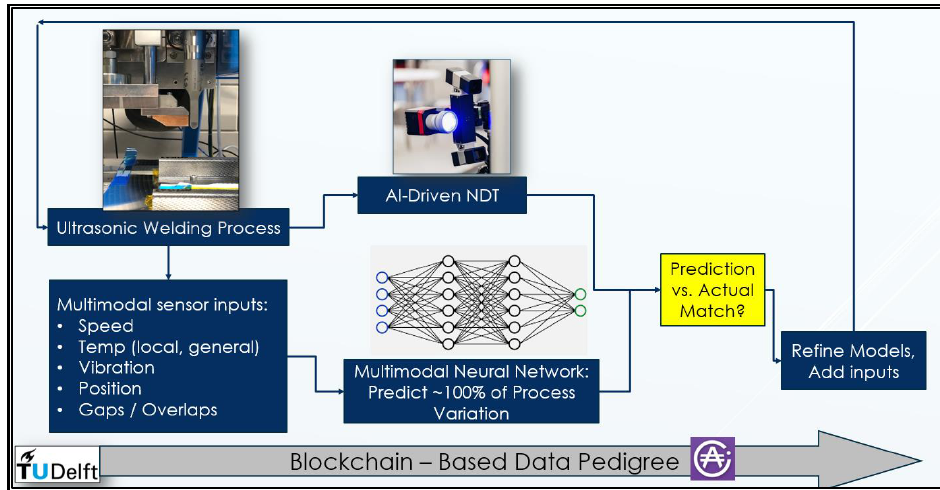
Figure 3. AI-driven process monitoring